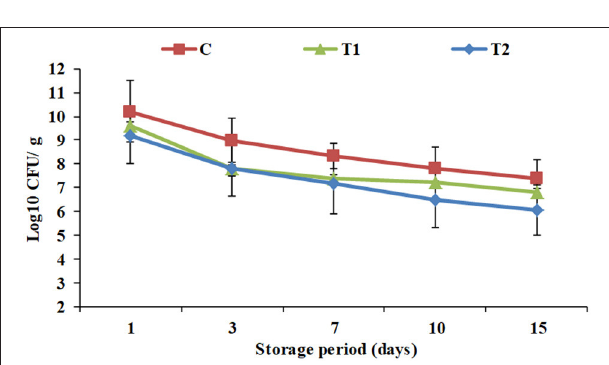
FIGURE 2 | Total viable counts of yogurt products during processing and cold storage. C, control plain yogurt; T1, Pro-WPI 10% WPI-enriched concentrated yogurt; T2, Pro-WPI 20% WPI-enriched concentrated